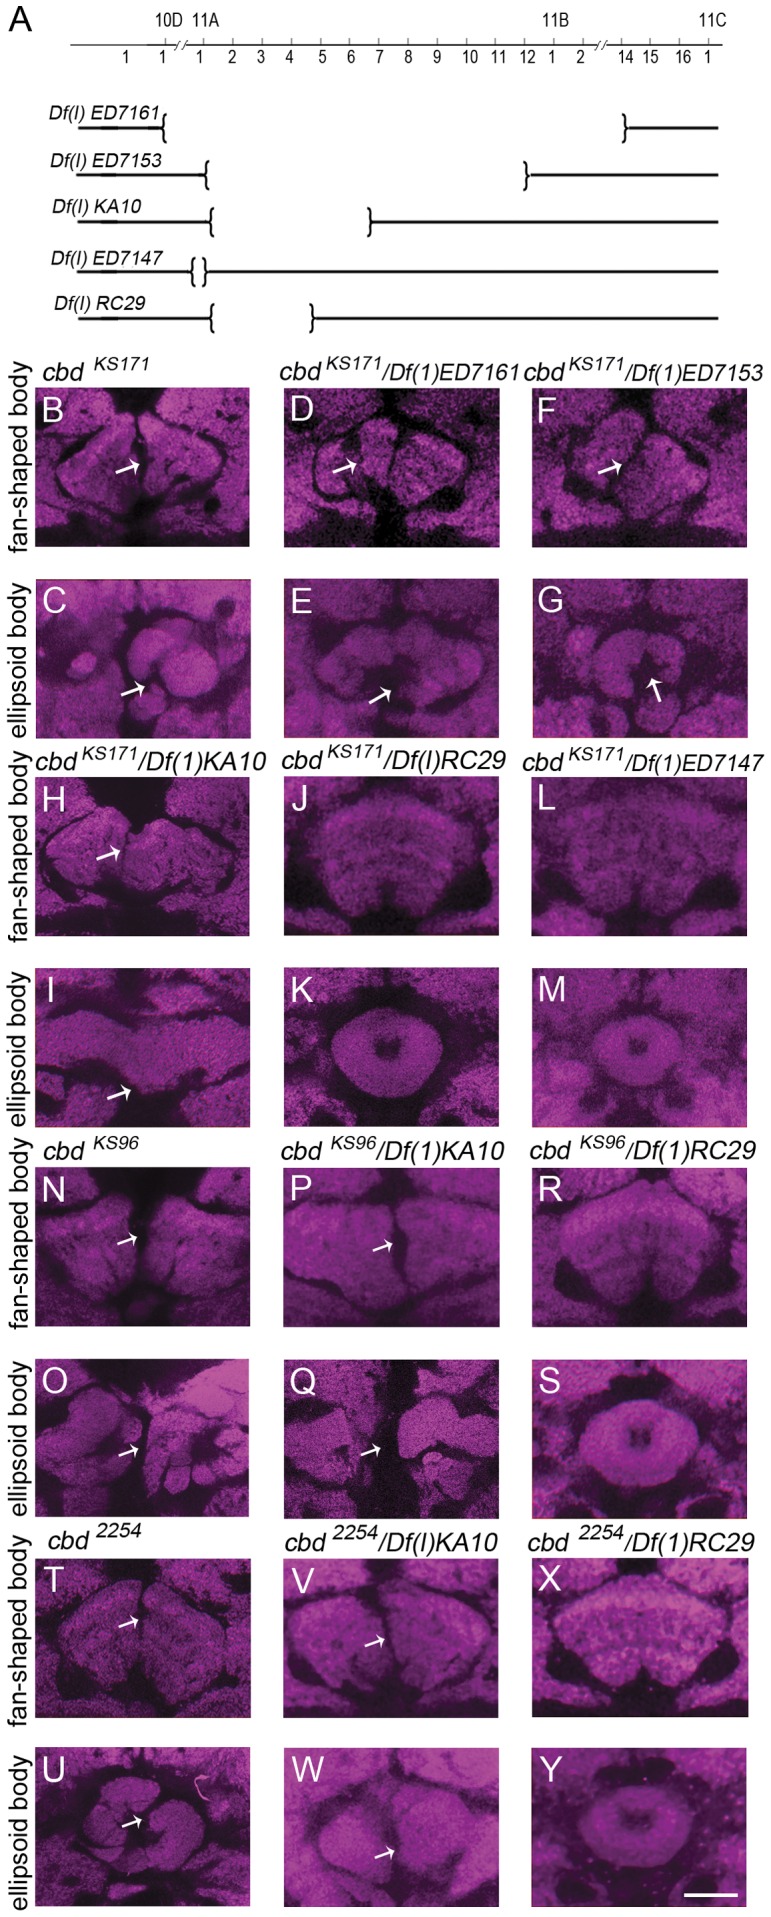
Morphology of the fan-shaped body (FB) and the ellipsoid body (EB) in the complementation test.(A) Schematic drawing of deleting regions of five deficiency lines on the X chromosome. (B, C) cbd KS171 mutant showed a defect in FB and EB. (D–I) complementation test cbd KS171 and Df(1)ED7161 (D,E) or Df(1)ED7153 (F,G) or Df(1)KA10 (H,I) showed a defect in FB and EB. (J–M) complementation test cbd KS171 and Df(1)RC29 or Df(1)ED7147 showed a normal FB and EB. (N, O) cbd KS96 mutant showed a defect in FB and EB. (P–S) complementation test between cbd KS96 and Df(1)KA10 showed a defect in FB (P) and EB (Q). cbd KS96 and Df(1)RC29 showed a normal FB (R) and EB (S). (T, U) cbd 2254 mutant showed a defect in FB and EB. (V–Y) complementation test between cbd 2254 and Df(1)KA10 showed a defect in FB (V) and EB (W) while that between cbd 2254 and Df(1)RC29 showed a normal FB (X) and EB (Y). Scale bar, 25 µm. Arrows indicate the central complex defect.